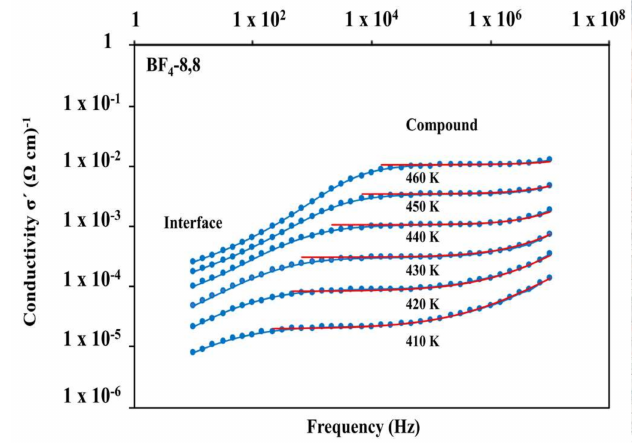
Figure 10. Representation of the real part of the conductivity vs. frequency for the derivative BF 4 -8,8 (7). Blue symbols correspond to the data, while red solid lines represent fits to the data at intermediate and high frequencies, where the main “compound” contribution is